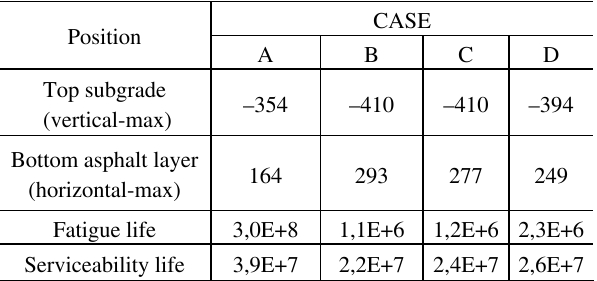
Table 3 . Horizontal and vertical strains in pavement